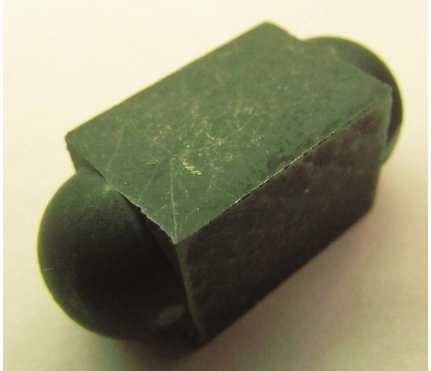
Figure 1: Specimen for abrasion tests.